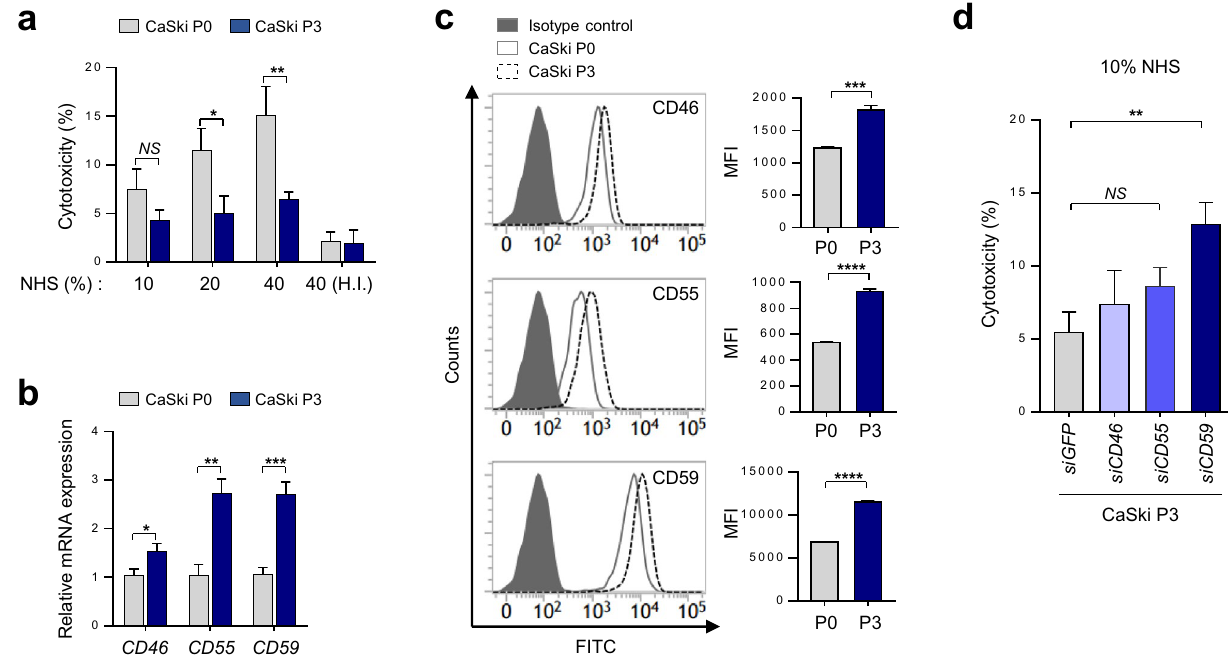
Figure 1. CTL-mediated immune selection confers resistance to CDC via up-regulating mCRPs. ( a ) Complement-dependent cytotoxicity (CDC) of CaSki P0 or P3 cells was measured by the Lactate dehydrogenase (LDH) release assay after incubation with the indicated concentrations of normal human serum (NHS). The heat-inactivated (H.I.) NHS served as negative control. ( b ) The mRNA expression of mCRPs, such as CD46, CD55, and CD59, in CaSki P0 or P3 cells was analyzed by real-time quantitative RT-PCR. ( c ) Protein levels of mCRPs were determined by staining with CD46, CD55, or CD59, followed by flow cytometry analysis. Data are presented as the mean fluorescence intensity (MFI). ( d ) CaSki P3 cells were transfected with siRNAs targeting GFP, CD46, CD55, or CD59. CDC of the transfected cells was measured by the LDH release assay. All experiments were performed in triplicate, and error bars represent standard deviations from the mean. Differences in cytotoxicity or expression level were statistically tested using two-way ANOVA ( a , b ), the Student’s t-test ( c ) or one-way ANOVA ( d ): * p < 0.05; ** p < 0.01, *** p < 0.001, **** p < 0.0001, NS , not significant.